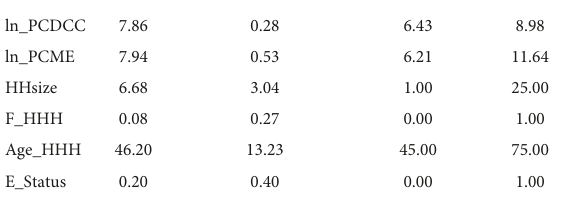
TABLE 1 Summary statistics of the variables used in semi-parametric